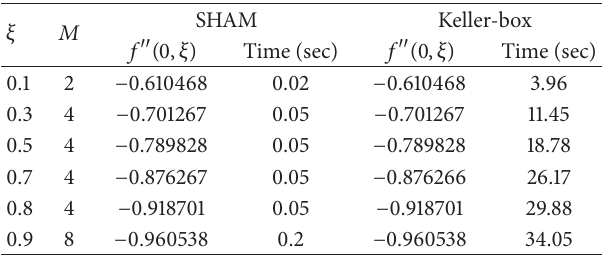
Table 1: Comparison between the SHAM and Keller-box numerical values of the skin friction 𝑓 󸀠󸀠 (0,𝜉) at different values of time 𝜉 when ℎ = −0.6